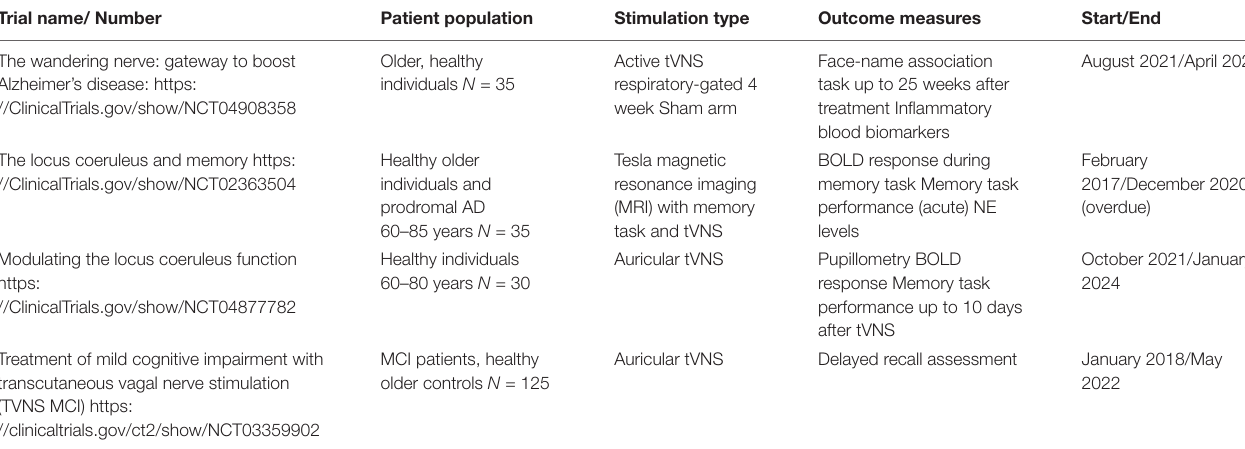
TABLE 1 | Current clinical trials of VNS in Alzhemer’s disease and